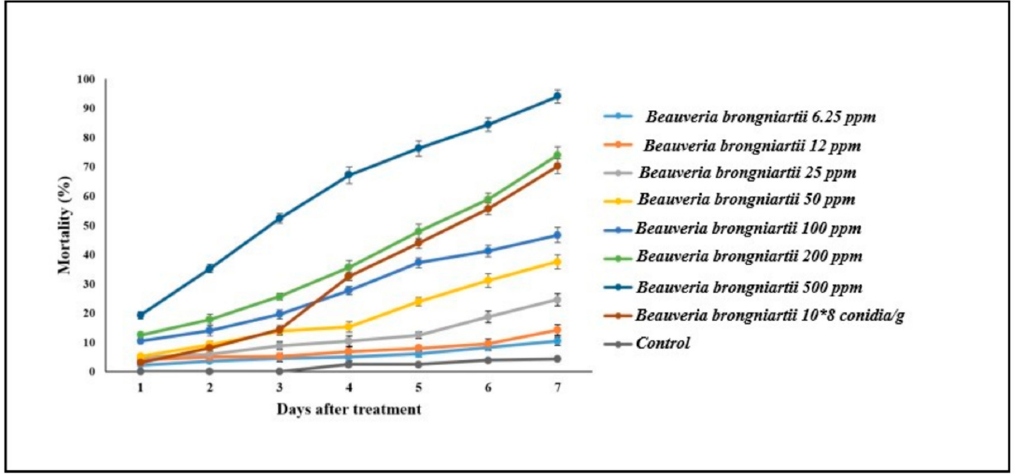
Figure 5. Percentage mortality of 2nd instar Spodoptera litura larvae in response to different treatments of Beauveria brongniartii Fe 0 NPs, B. brongniartii, and control at different time intervals. * Treatments (T1–T9) are outlined in Table 1. Error bars indicate the standard error of means. The LC 50 values of Fe 0 NPs against S. litura after 7 days of fungal treatment was 58 ppm (Table 2). The LT 50 values for 200 and 500 ppm concentrations of Fe 0 NPs against S. litura 7 days post- treatment were 5.10 and 2.29 days, respectively (Table 3). Table 2. Median lethal concentration (LC 50 ) values of Beauveria brongniartii Fe 0 NPs against Spodoptera litura estimated by probit regression. Treatment Time(Days)